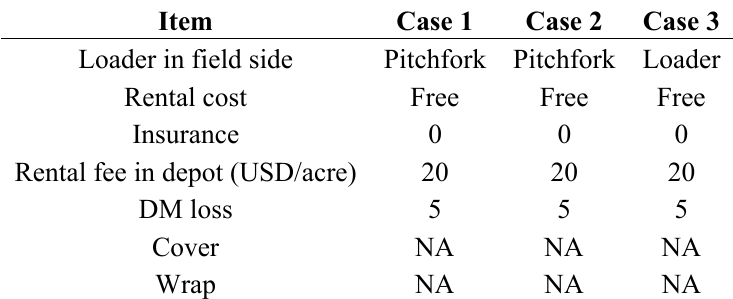
Table A3. Equipment and other elements used during storage.